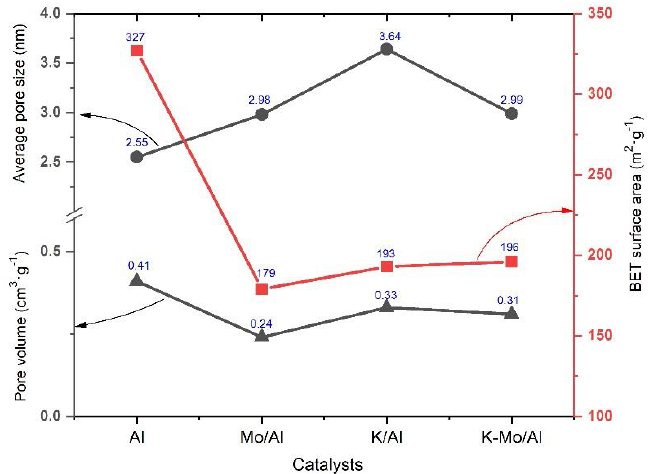
Figure 2. The textural parameters of Al, Mo/Al, K/Al and K-Mo/Al